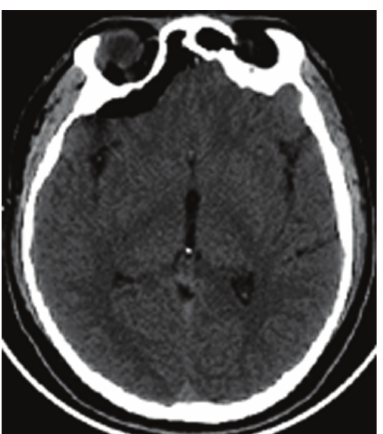
Figure 3: Head CT without contrast demonstrating complete removal of